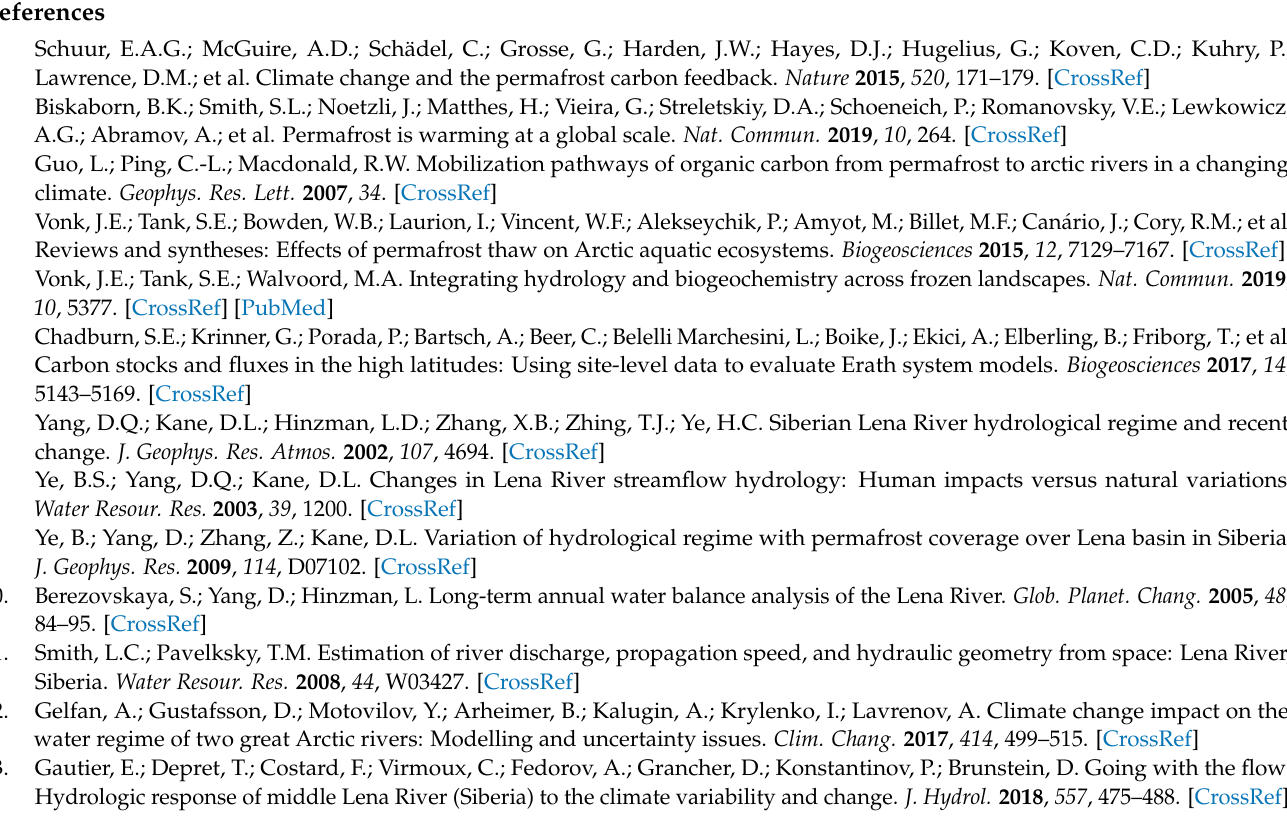
Figure S2: Results of PCA treatment of the Lena River tributaries chemical composition, including landscape parameters. Table S1: Physico − geographical parameters of the studied Lena River tributaries; Table S2: Mann − Whitney test of the difference in element concentration in the upper (0 − 800 km) and middle (800 − 2600 km) course of the Lena River main stem; Table S3: Pearson correlation coefficients ( p < 0.05) of major and trace elements with three main potential carriers— DOC, Fe and Al in the main stem of the Lena River and its tributaries; Table S4: Pearson correlation matrix of landscape parameters and river water